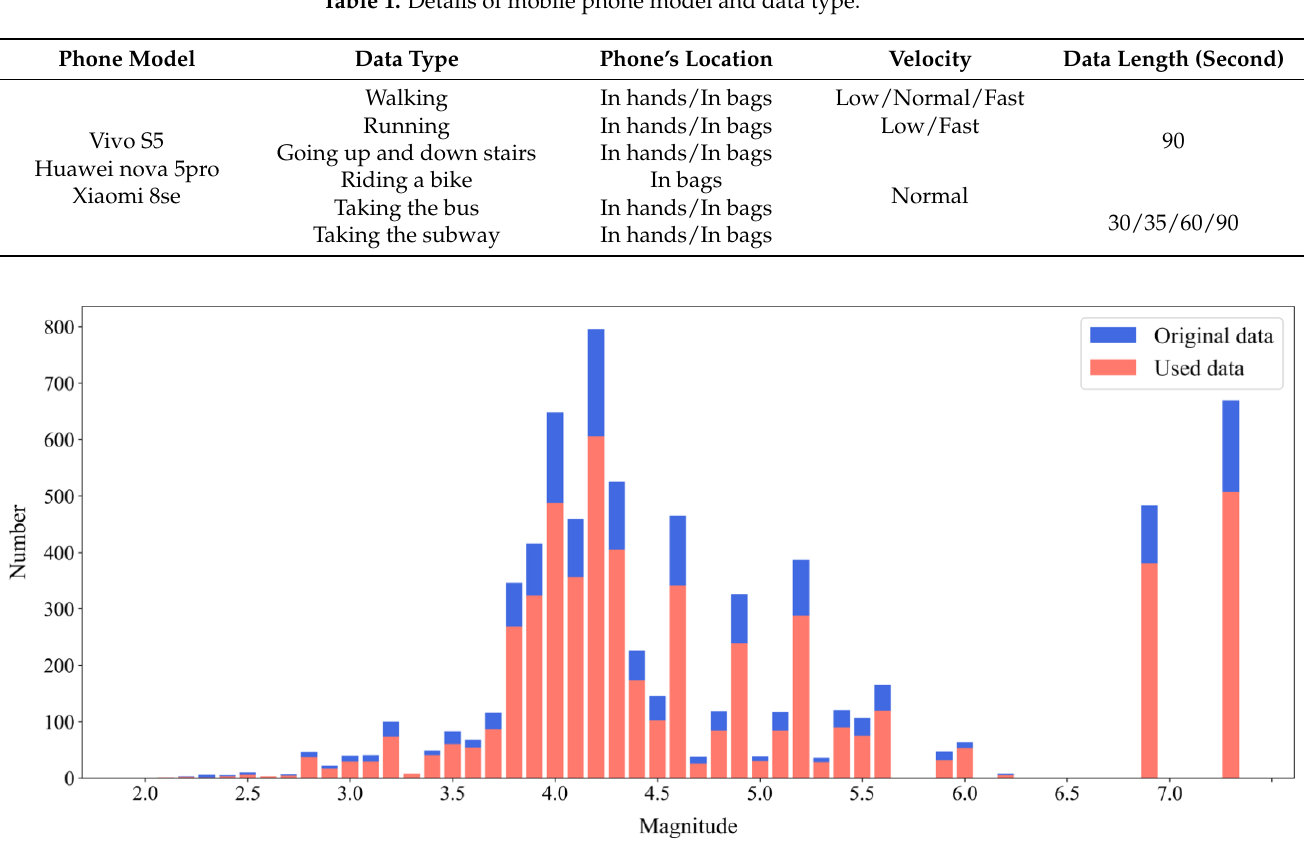
Figure 2. Histogram of the number of selected traditional strong-motion records as a function of magnitude in this paper.